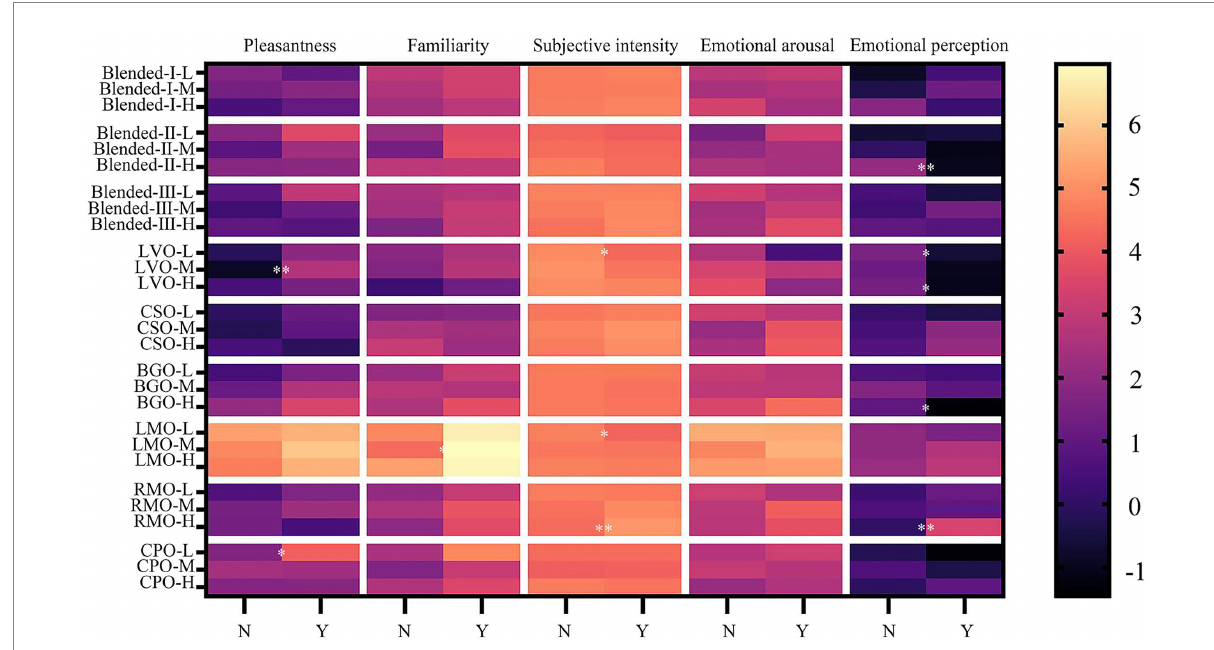
FIGURE 5 Effect of fragrance usage habits on sensory evaluation of odor. Mean ratings ( n = 24–26) at three concentrations on pleasantness, familiarity, subjective intensity, emotional arousal, emotional perception and at low (L), mid-range (M), and high (H) concentration of the participants without fragrance usage habits and the participants with fragrance usage habits. N: participants without fragrance usage habits, Y: participants with fragrance usage habits. The asterisk indicates that the odor evaluation results of the two groups show significant differences. * p < 0.05, ** p < 0.01. Data were analyzed by two-way mixed ANOVAs, a post hoc Bonferroni test was